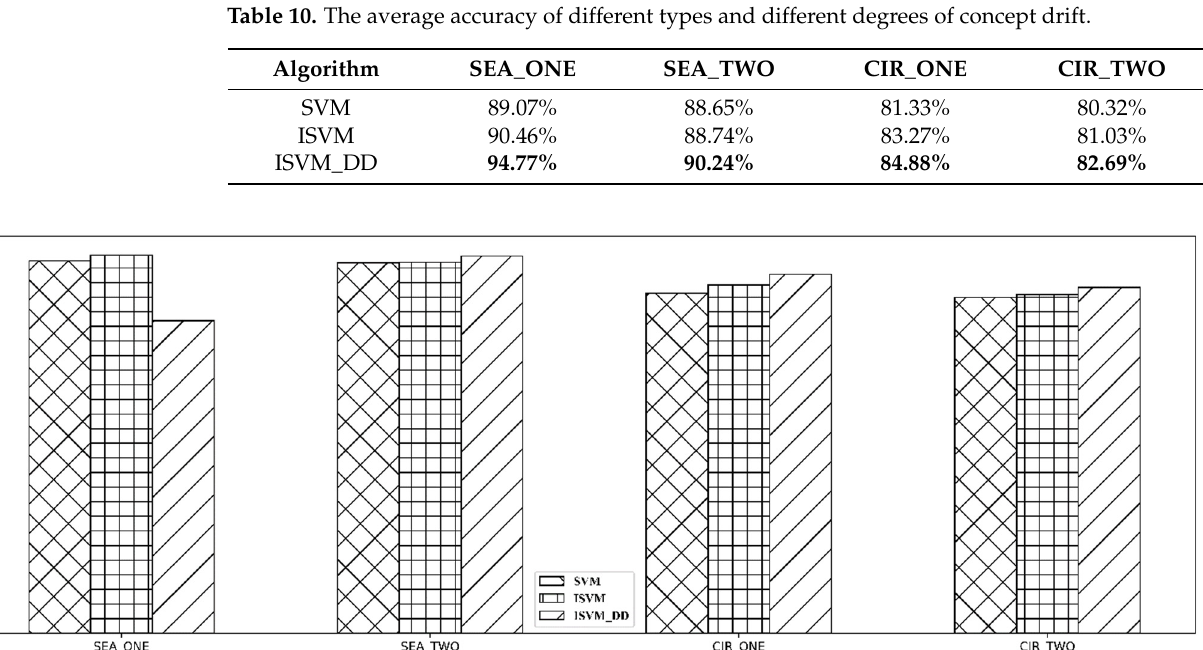
Table 10. The average accuracy of different types and different degrees of concept drift.